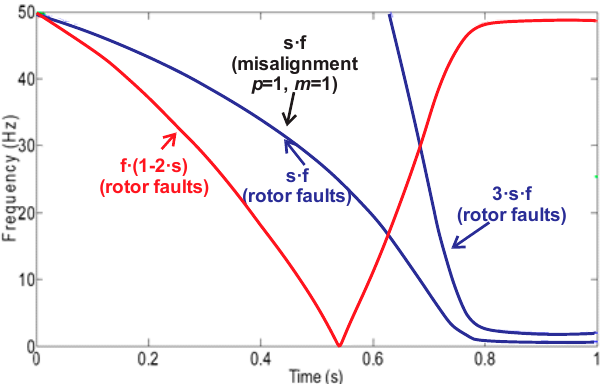
Figure 2. Theoretical evolutions under the starting for the broken bar–related components (axial and radial) and for the misalignment components.